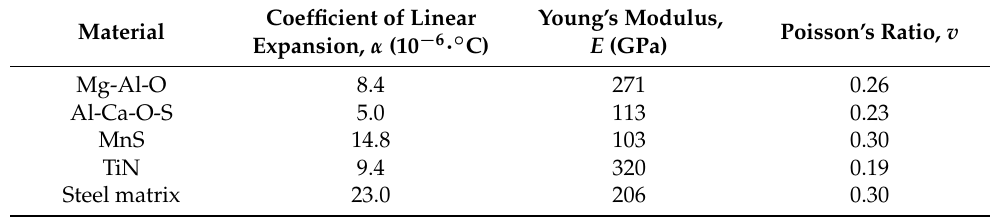
Table 3. Mechanical properties of the steel matrix and the inclusions in the martensitic steel